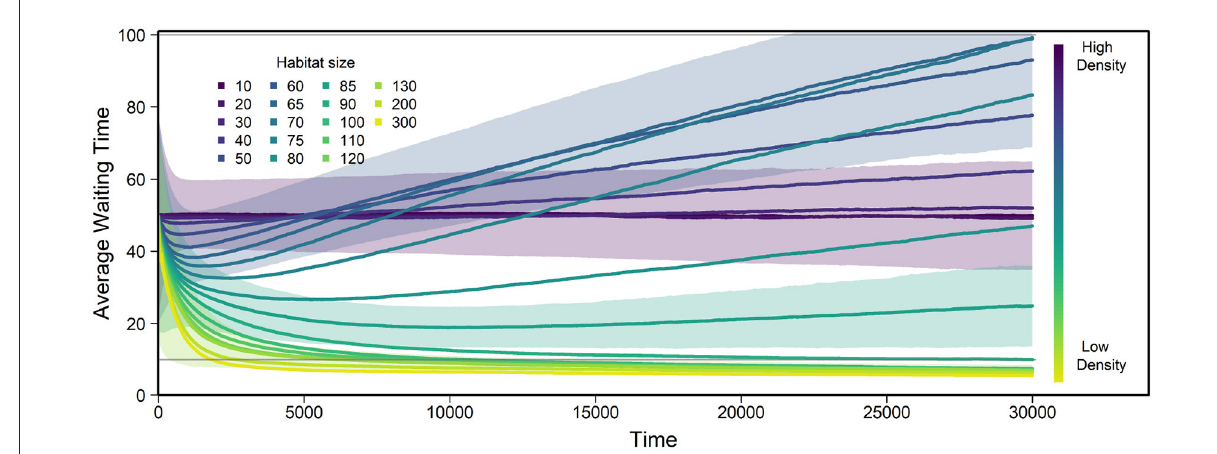
FIGURE3 Evolution of average WT over all individuals and replicates using the default parameters described in Table 1 and various habitat sizes g . The color bar shows how g relates to density, e.g., lower values of g indicate higher density. Number of replicates = 1,000. Generations overlap, but average lifespan is 100 days, meaning the graph shows approximately 300 life spans. At low densities (yellow), average WT decreases, at intermediate densities (teal/blue) it increases, while it stays approximately constant on average for high densities (indigo/purple). The gray horizontal lines indicates the sperm storage duration (10), and average lifespan (100), below and above which we expect selection to weaken. Shaded areas show standard deviations across replicates for habitat sizes 10, 60, 85, and 130.